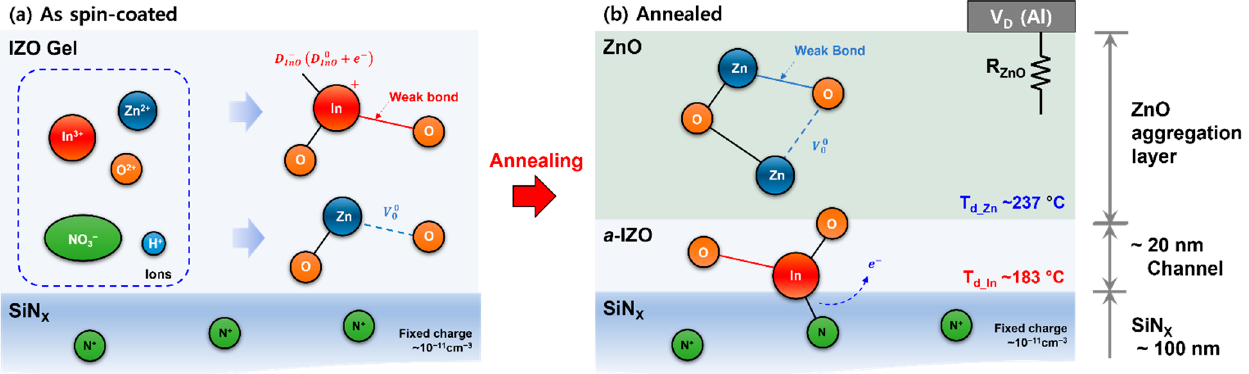
Figure 8. ( a ) Illustration of types of ions in gel-state a -IZO film after spin coating and the simplest atomic structure by oxidation. ( b ) Schematic of multi-layer a -IZO film and possible atomic structures of by-product through the annealing process.